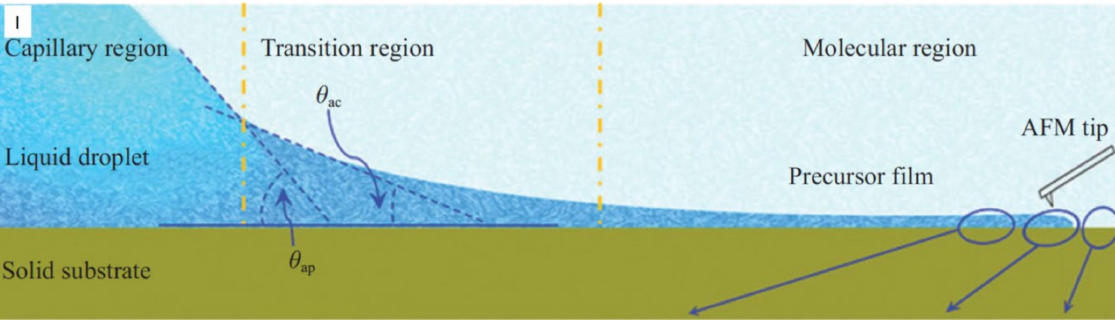
Figure 3. Multi-scale representation of the physics of contact line dynamics